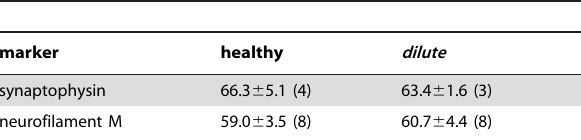
Table 2. Coverage of BGT-positive area by presynaptic markers in healthy and dilute muscles.